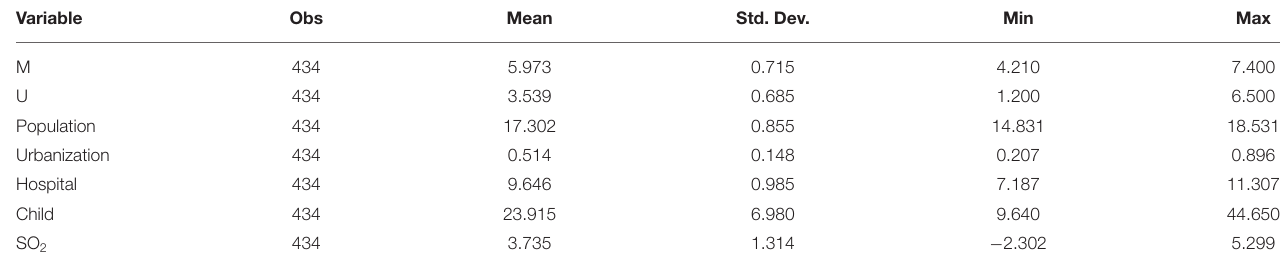
TABLE 2 | Descriptive